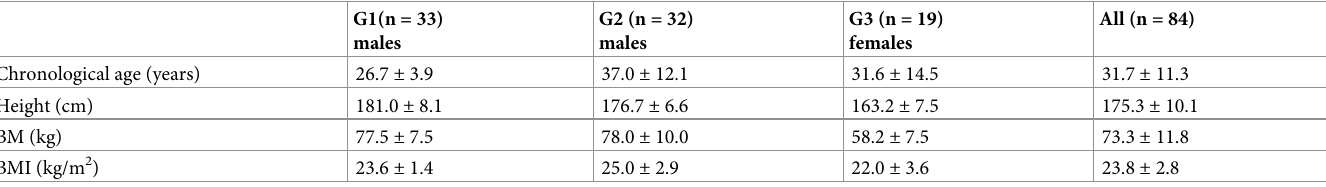
Table 1. Descriptive statistics of somatic characteristics (mean ±